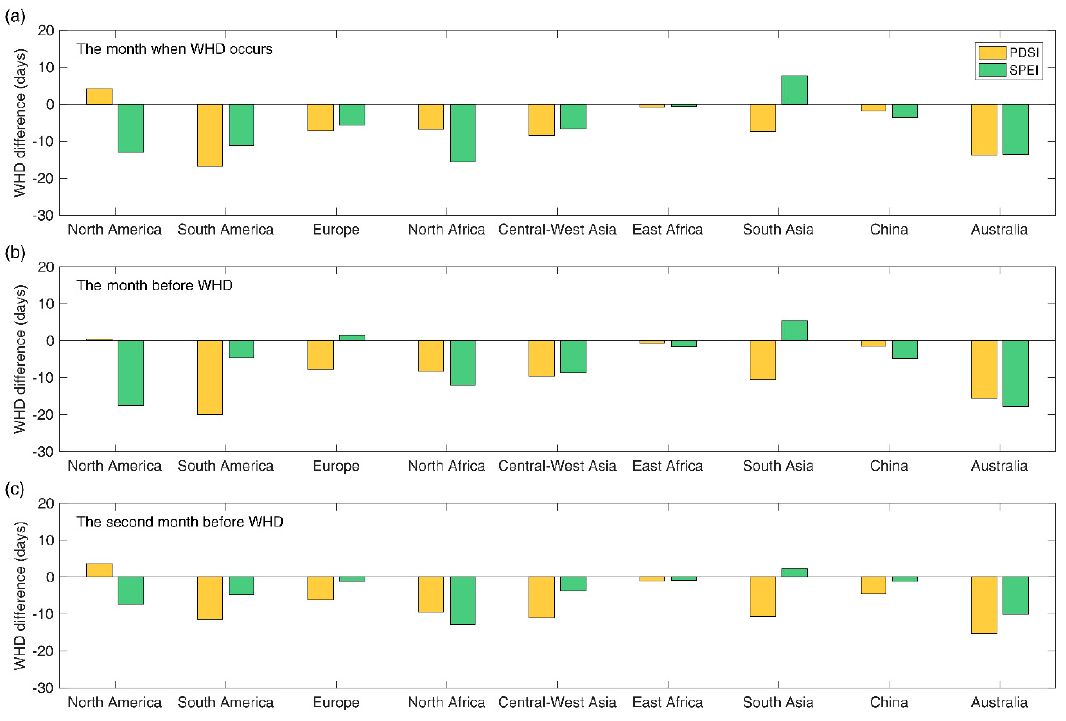
Figure 7. Di ff erence in WHD between extreme-drought years and normal years based on PDSI (yellow) and SPEI (green). ( a ) Drought conditions in the month when WHD occurs; ( b ) drought conditions in the month before WHD; ( c ) drought conditions in the second month before WHD.